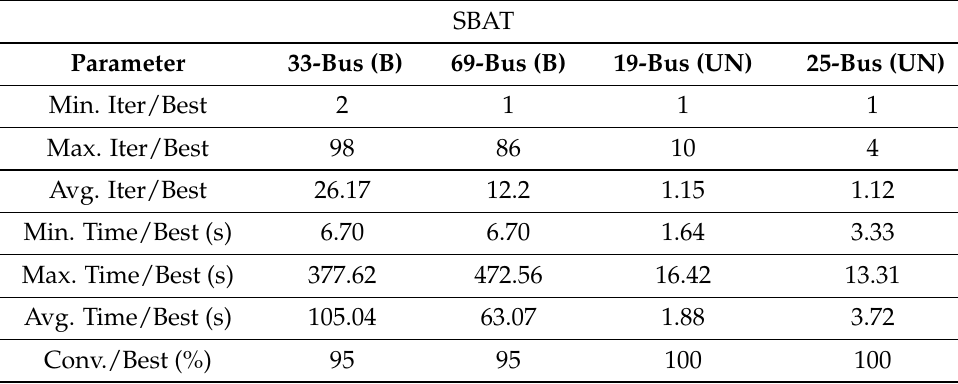
Table 18. Convergence analysis SBAT/SPSO—variable